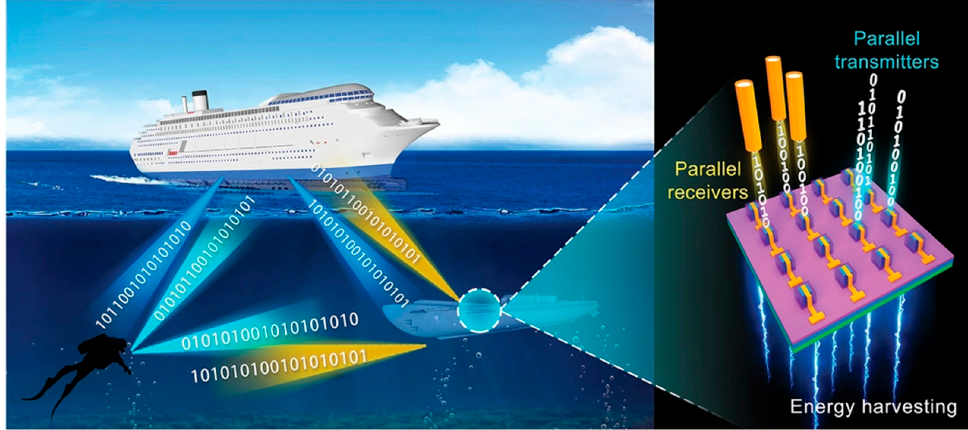
Figure 16. Illustration of application scenarios of duplex UWOC and charging technologies based on a micro-LED array [131] . Figure reused with permission from John Wiley and Sons.